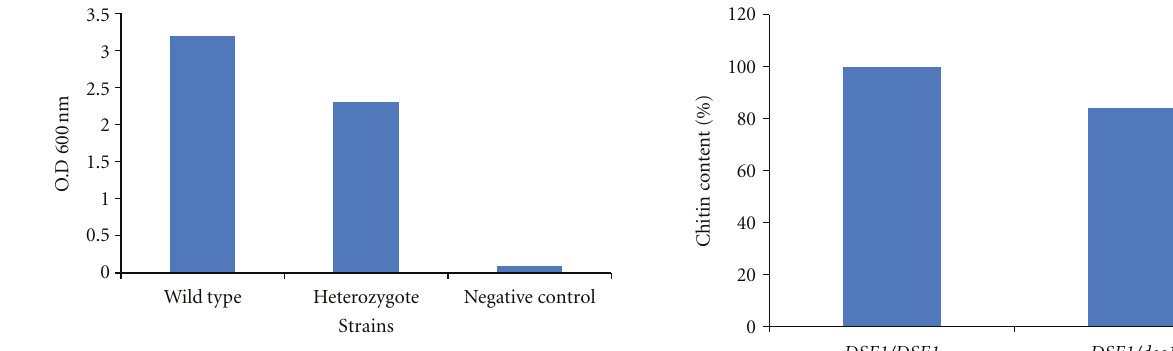
Figure 5: Chitin content. Cell wall chitin content was measured as absorbance at OD600 of N-acetylglucosamine monomers released after HCl hydrolysis of 50mg purified cell walls. Mutant chitin content was 84% that of the wild type ( P = .